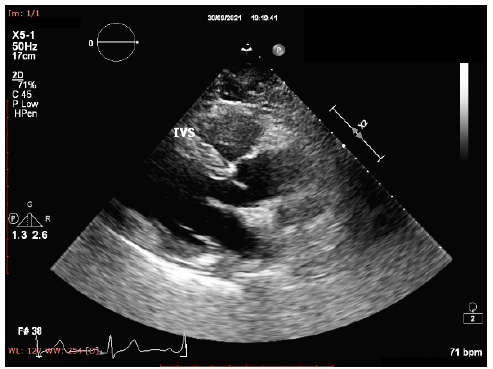
Figure 6. 2D Echocardiography, parasternal long-axis view showing concentric left ventricle hyper-